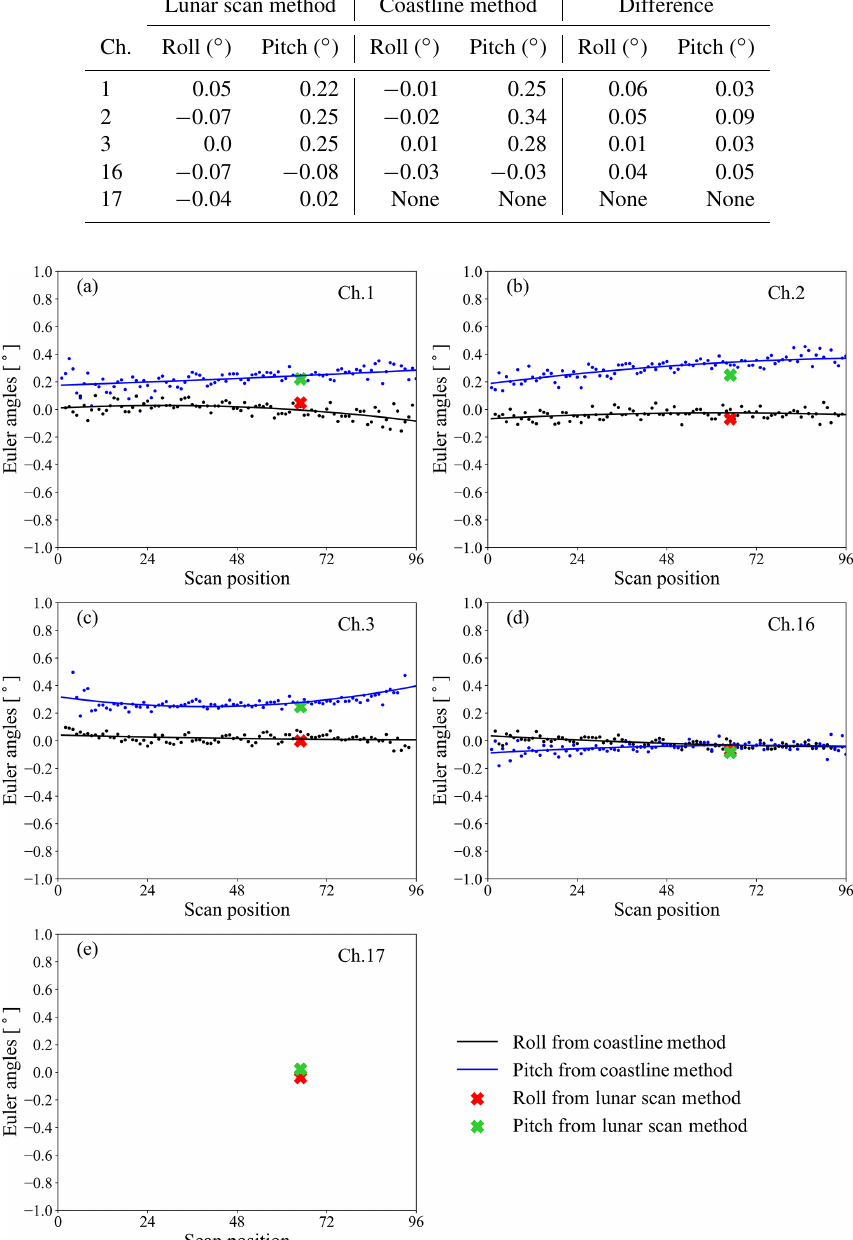
Figure 7. Comparison between the Euler angles retrieved from the coastline inflection point method and those from the lunar scan